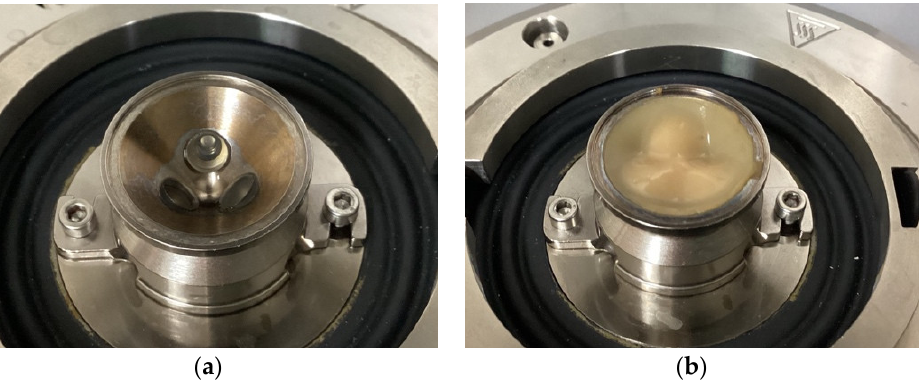
Figure 1. Detailed view of the sample holder with PDMS pins: ( a ) empty; ( b ) sample after measurement.